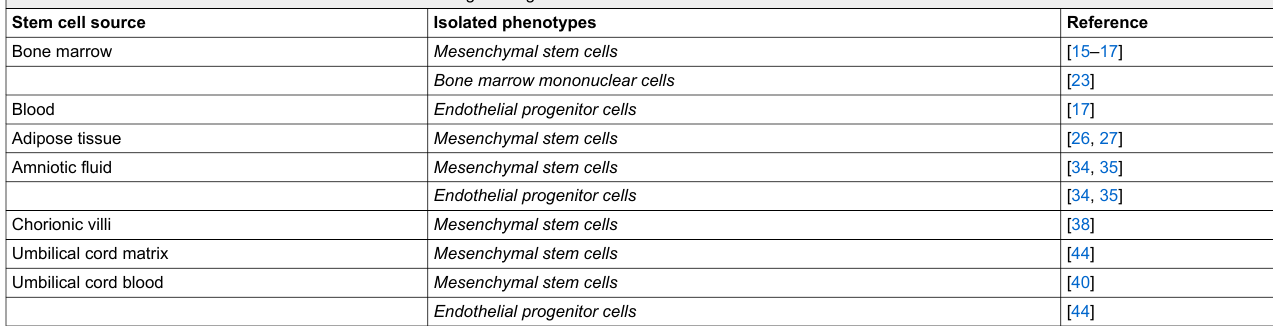
Table 1: Available stem cell sources for heart valve tissue engineering. Stem cell